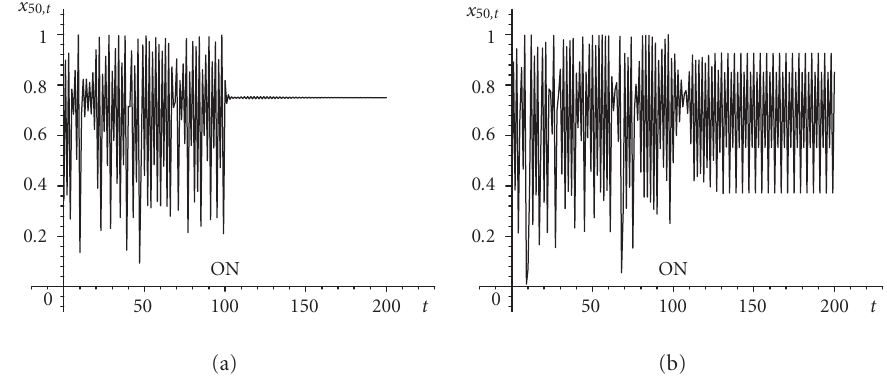
Figure 6.1. Simulations for a weakly coupled map lattice system ( (cid:1) 1 = 1 / 5 (cid:9) (cid:1) ∗ ): (a) (cid:1) = 1 / 5, γ = 0 . 35, (b) (cid:1) = 1 / 5, γ = 0 . 15. The adaptive adjustment is trigged at 101th step. Initial states are given randomly around 0 . 3333.